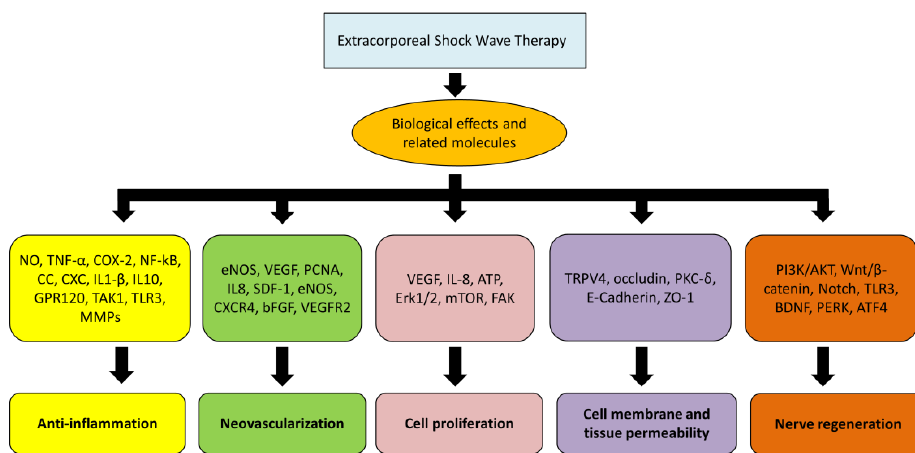
Figure 3. Biological effects and related molecules after ESWT.